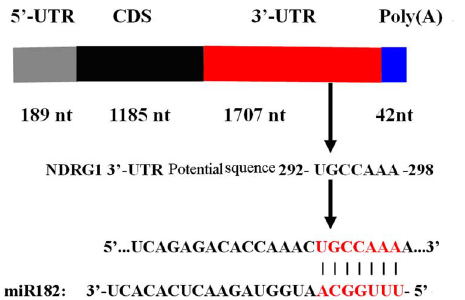
Figure 9. Schematic digram of NDRG1 3 9 -UTR region targeted by miR-182. NDRG1 3 9 -UTR region has only one highly conserved miR- 182 binding sites after bioinformatic analysis.